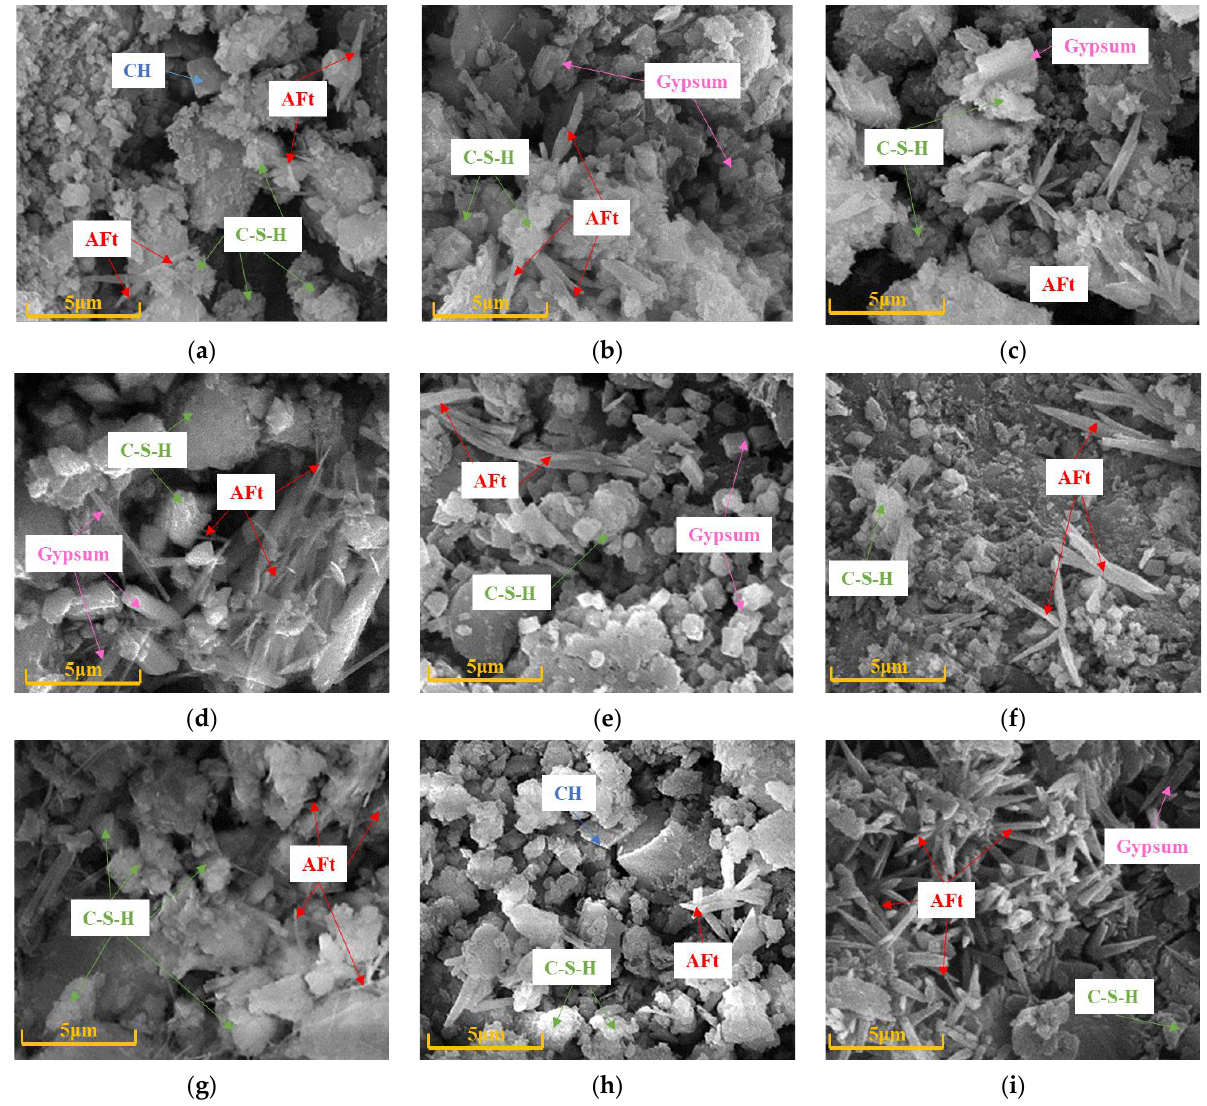
Figure 9. SEM images of different sulfate-attacked CGC specimens: ( a ) CGC30S10-28 d; ( b ) CGC30S10-60 d; ( c ) CGC30S10-120 d; ( d ) CGC30S10-240 d; ( e ) CGC20S10-120 d; ( f ) CGC40S10-120 d; ( g ) CGC30S0-120 d; ( h ) CGC30S5-120 d; ( i ) CGC30S15-120 d.